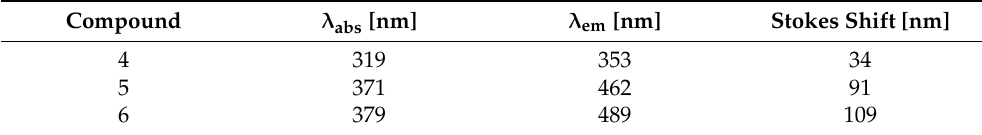
Table 1. Optical properties of unoxidized and oxidized bisphosphonates 4 – 6 recorded in di- chloromethane.